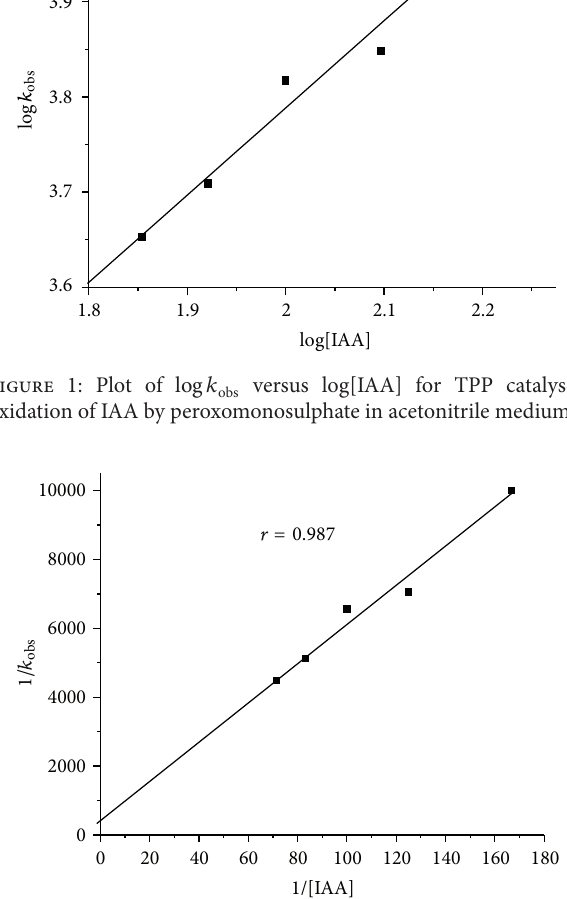
F 2: Plot of 1/ versus 1/[IAA] for TPP catalysed oxidation obs of IAA by peroxomonosulphate in acetonitrile 𝑘𝑘